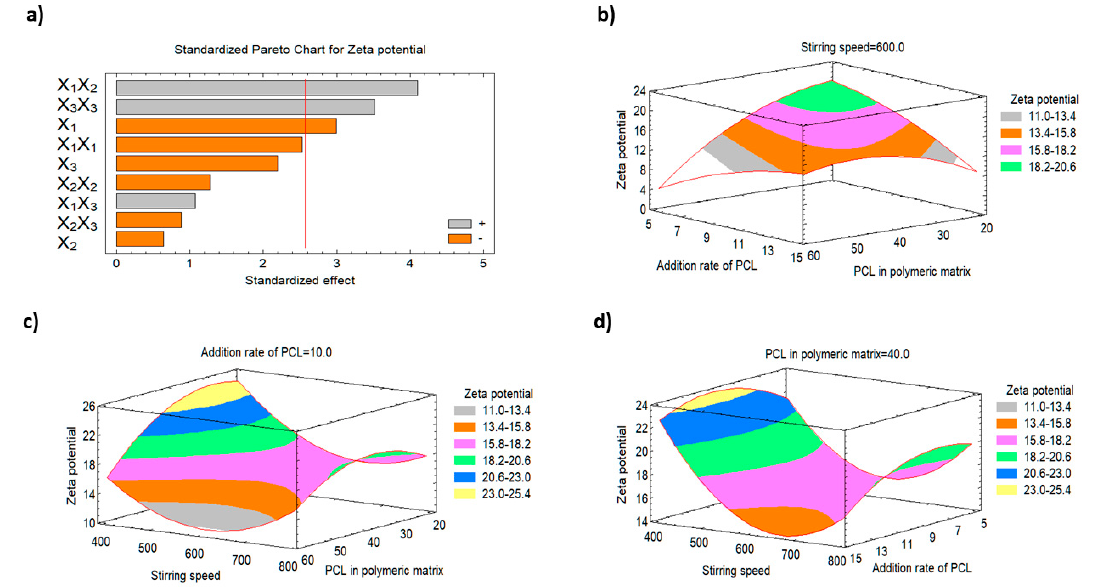
Figure 2. Pareto chart and the three-dimensional response surface plots representing the effect of changing the variables levels on the zeta potential (Y2). ( a ) Standardized Pareto chart for zeta potential. ( b ) The three-dimensional response surface plot of the effect of stirring speed on zeta potential (Y2). ( c ) The three-dimensional response surface plot of the effect of addition rate of PCL on zeta potential (Y2). ( d ) The three-dimensional response surface plot of the effect of PCL in polymeric matrix on zeta potential (Y2).